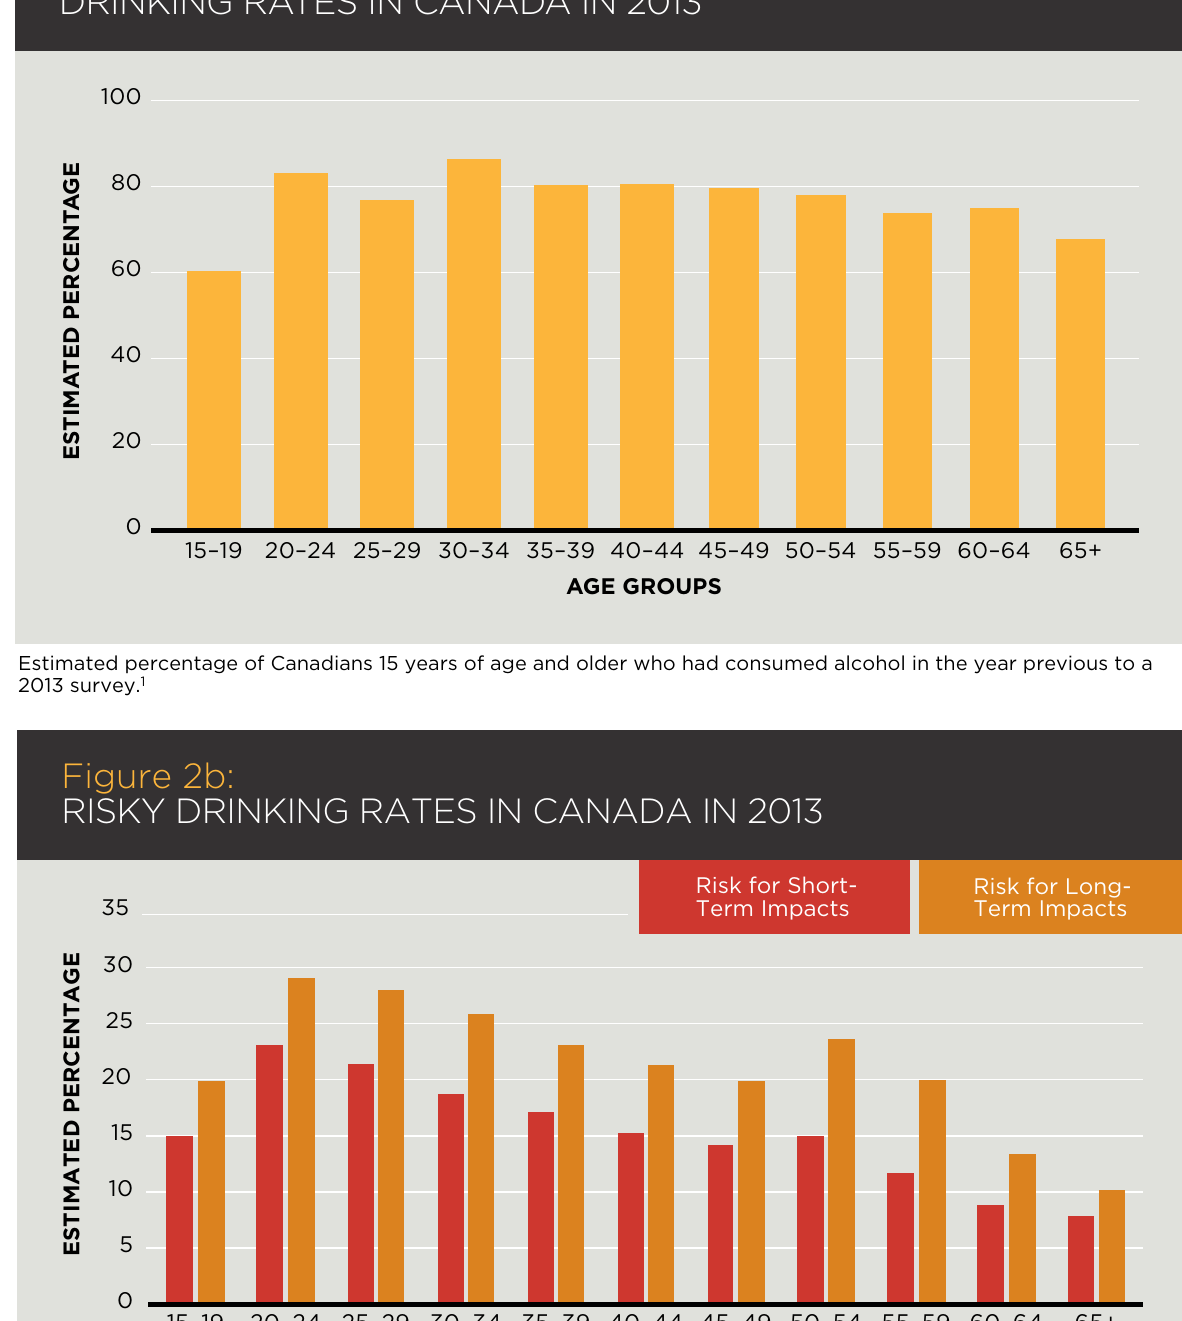
DRINKING RATES IN CANADA IN 2013